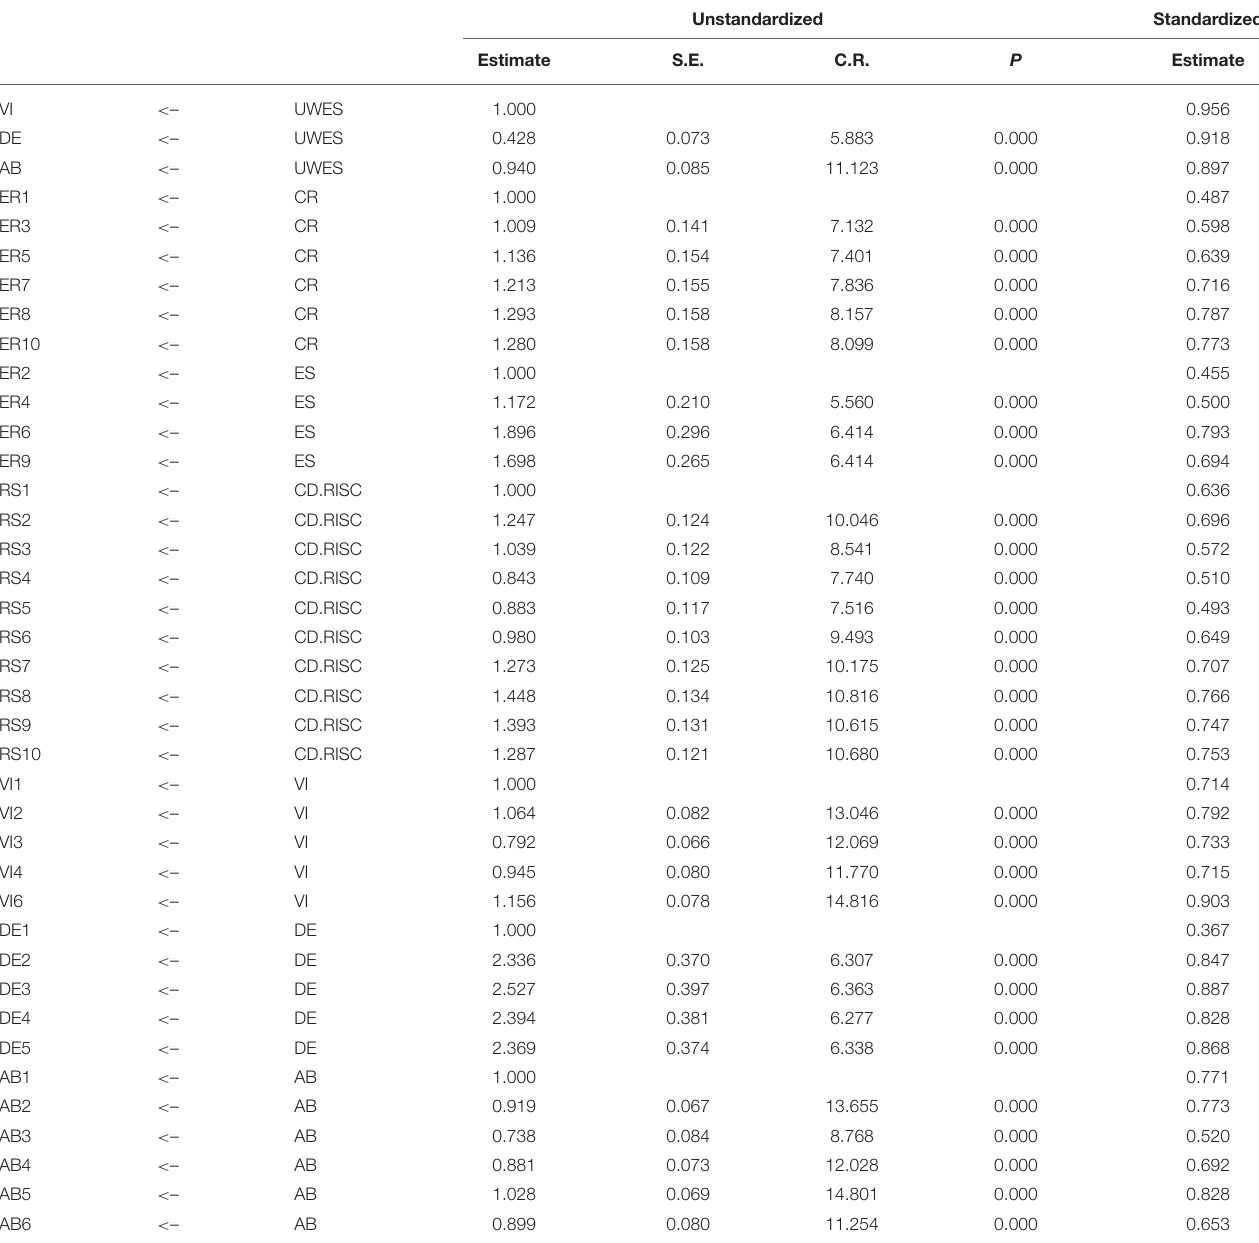
TABLE 1 | Unstandardized and standardized estimates of the initial CFA